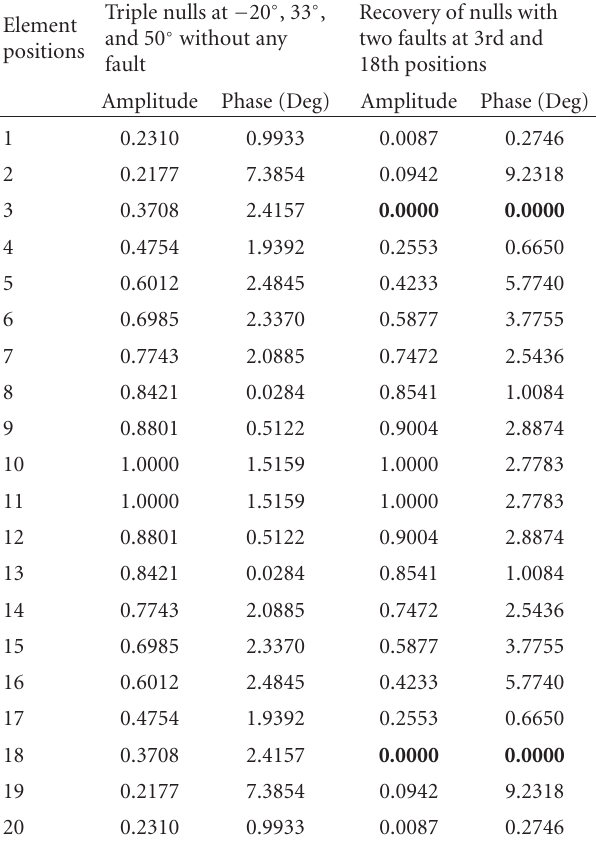
Table 5: Element excitations corresponding to Case 3. Element